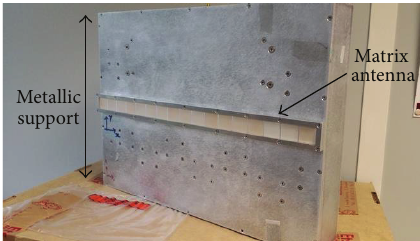
Figure 4: Matrix antenna manufactured prototype placed at the top of a metallic support.